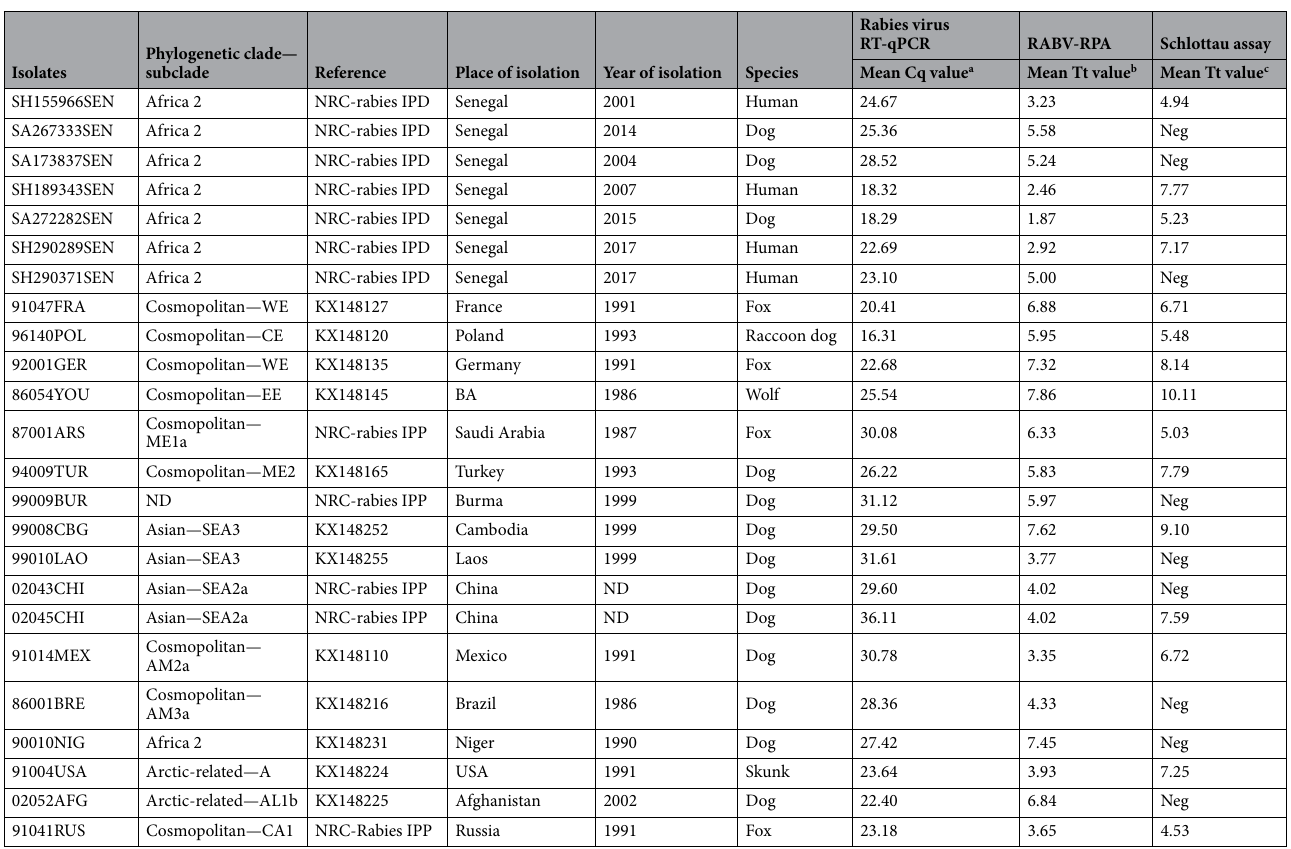
Table 2. Assessment of detection spectrum of the RABV-RPA assay versus real-time RT-qPCR and the Schlottau assay. Tt: time threshold in minutes, BA: Bosnia and Herzegovina, Neg: negative; no cross-reactivity, Cq: quantitative cycle, NRC-Rabies IPD: national reference center for rabies virus (NRC-Rabies) at Institut Pasteur de Dakar, BP 220, Dakar, Senegal, NRC-Rabies IPP: national reference center for rabies virus (NRC- Rabies) at Institut Pasteur, Paris, France. a Mean Cq value from duplicates with the previously described RABV- L-protein real-time RT-qPCR assay by Faye et al. used as reference test 19 . b Mean Tt value from duplicates given by the RABV-RPA assay. c Mean Tt value from duplicates obtained with the Schlottau assay 21